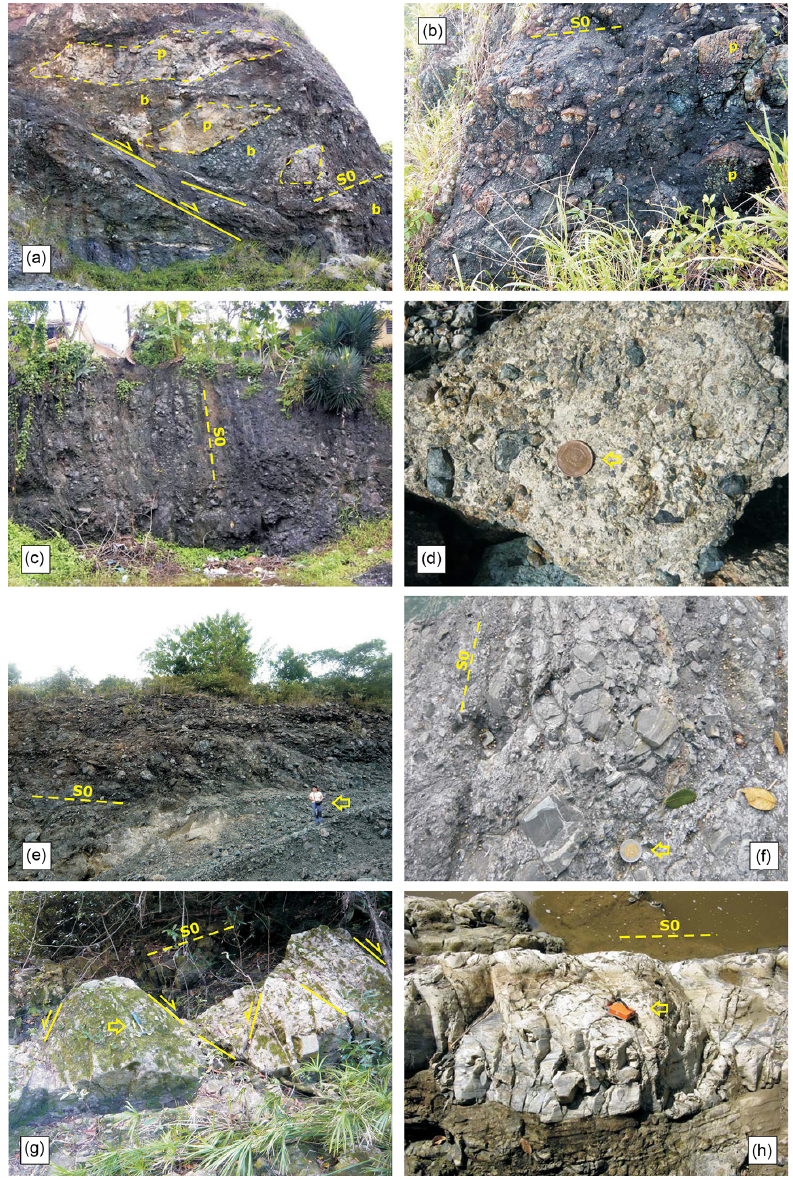
Figure 5. Field photographs of Imbert Fm. (a) Os facies assemblage composed of lensoidal serpentinite blocks in a heterogeneous and faulted matrix composed of breccia, sandstone, and mudstone. Note serpentinized peridotite blocks ( p ) randomly distributed in a polymictic brecciated matrix (b) and the structureless layers of silts and muds. Angular block attains several metres in size. IM3 unit, Gaspar Hernán- dez section. (b) Gm facies assemblage composed by serpentinite-rich, massive breccia and matrix-supported, muddy–sandy (polymictic) conglomerate. Note the serpentinized peridotite ( p ) nature of the clast in the breccia. IM3 unit, Loma Seboruco section. (c) Gp facies as- semblage composed of clast-supported, sandy (polymictic) breccia and conglomerate. Note inverse-to-normally graded internal structure, dominant clast-supported fabric. Massive internal structure also occurs. Breccia beds are often lenticular with erosive base and interbedded with pebbly conglomerate and coarse-grained sandstone. IM3 unit, Gaspar Hernández section. (d) Detail of matrix-supported breccias of IM3 unit (Gm facies assemblage). Clast shown a random orientation and compositionally are of (mainly) serpentinite, red/green volcanic rocks, laminated sandstone and (rare) white limestone. IM3 unit, Gaspar Hernández section. (e) Gm facies assemblage typical of IM3 unit composed by massive breccia and matrix-supported, muddy–sandy (polymictic) breccia and conglomerate. Note in the breccia body the disorganized internal structure, pebble to cobble size, often erosive base, and random clast orientation of (mainly) serpentinite. (f) Strata disruption by layer-parallel extension in lithified medium thick sandstones controlled by conjugate extensional fractures and pinch-and-swell structures. Note as disrupted layers are fossilized by younger breccia strata. IM2 unit, Río Obispo section. (g) Conjugate sets of normal fault zones deforming the bedding (S0) surfaces of a thick bedded coarse-grained sandstone-laminated mudstone alternating sequence. Note as small faults are fossilized by younger sandstone strata. IM2 unit, Río Obispo section. (h) Tv facies assemblage typical of IM1 unit composed of fine-grained tuff with alternating fine-grained tuffaceous sandstone and mudstone. Río Obispo section. www.solid-earth.net/7/11/2016/ Solid Earth, 7, 11–36,